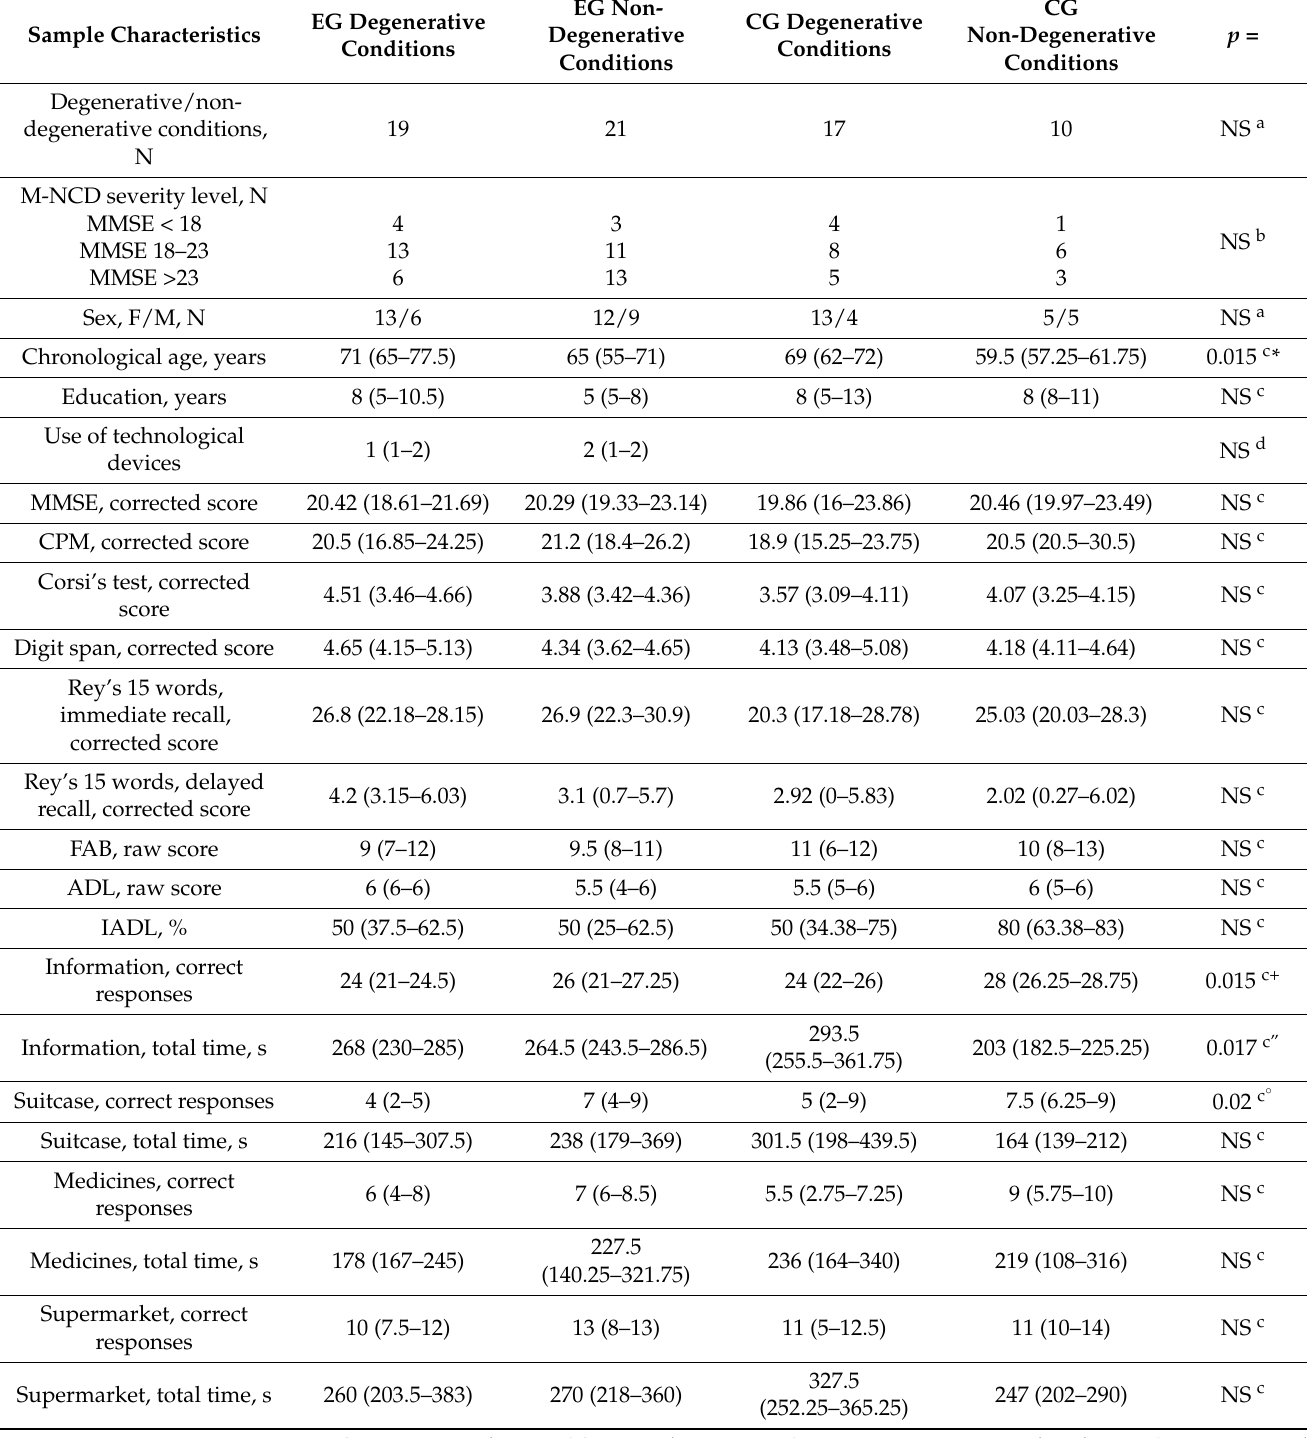
Table 1. Comparison of the characteristics of patients with degenerative or non-degenerative condi- tions in the experimental and control groups at T1. If not otherwise specified, values are expressed as the median (interquartile range). Corrected scores refer to the age- and education-corrected